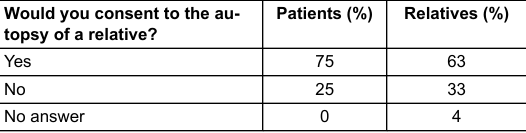
Table 6: Consent to the autopsy of a relative (questionnaire 1).